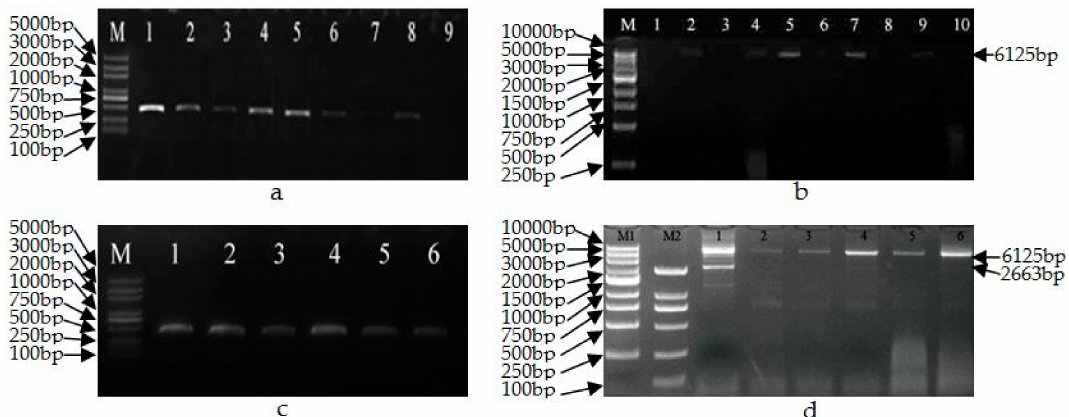
Figure 3. PCR identification of the transgenic plants before ( a , b ) and after ( c , d ) heat-shock